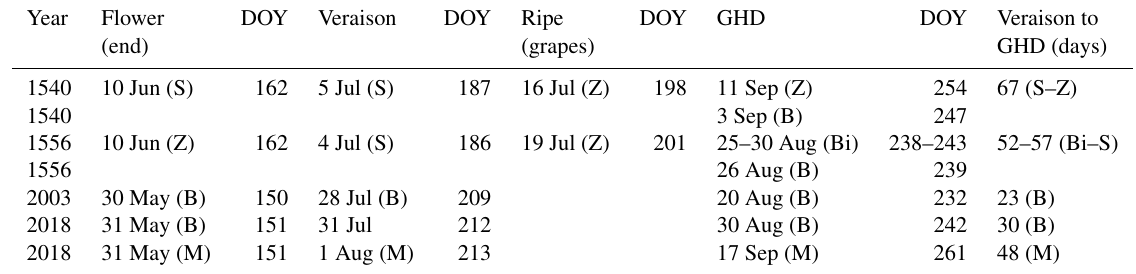
Table 6. Phenological stages (flowering, veraison, ripening of the grapes and harvest dates) of the vine during extremely early years. S (Schaffhausen, white Räuschling cultivar); Z (Zürich, white Räuschling); Bi (Biel–Bienne, white Chasselas), M (Malans, red Pinot noir), B (Beaune, red Pinot